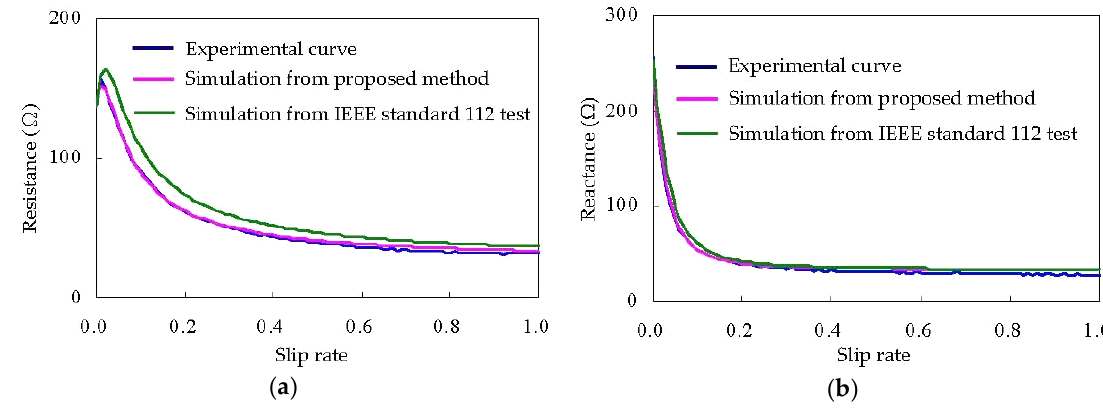
Figure 6. Parameter estimation results in the field test. ( a ) Input resistance comparison; ( b ) Input reactance comparison.